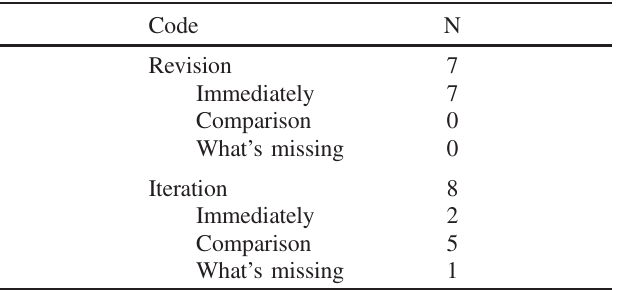
TABLE III. Prevalence of the revision and iteration codes at any point during the subsection of the interview analyzed for